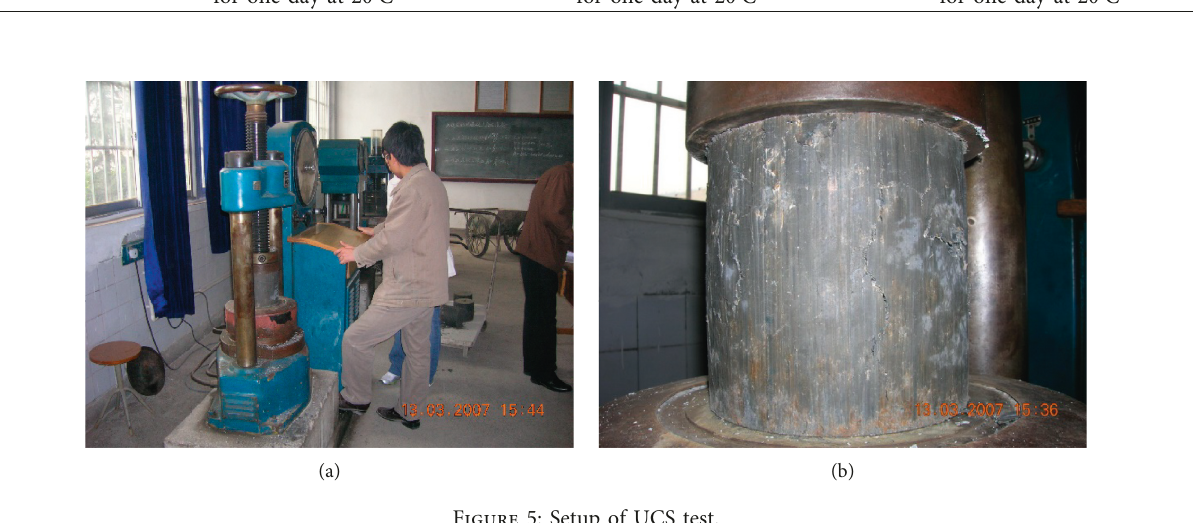
Figure 5: Setup of UCS test.